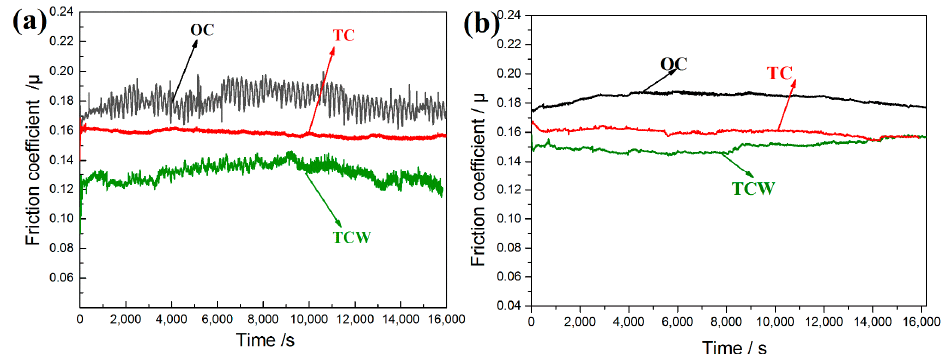
Figure 3. The friction coefficient of different cylinder samples at different temperatures after running-in stage; ( a ) at the temperature of 200 °C, ( b ) at room temperature.